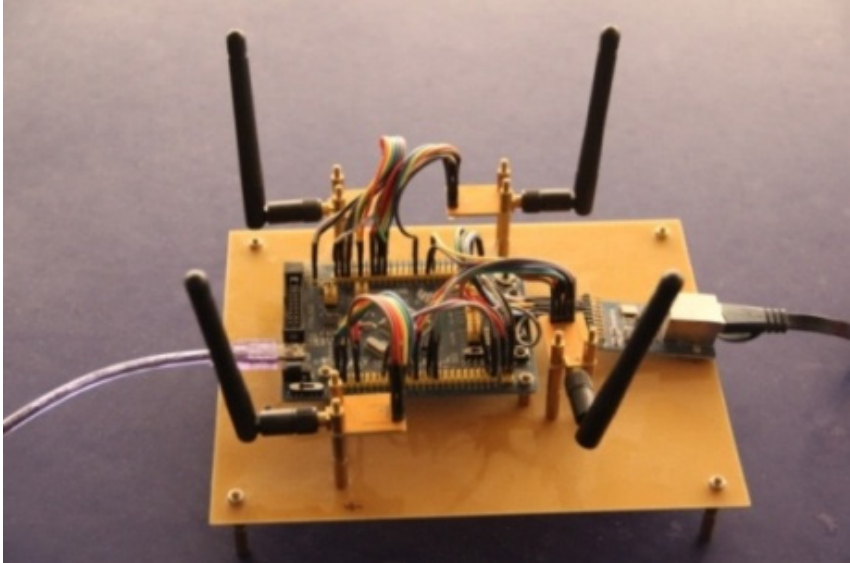
Figure 4 . The composition module of wireless gateway.